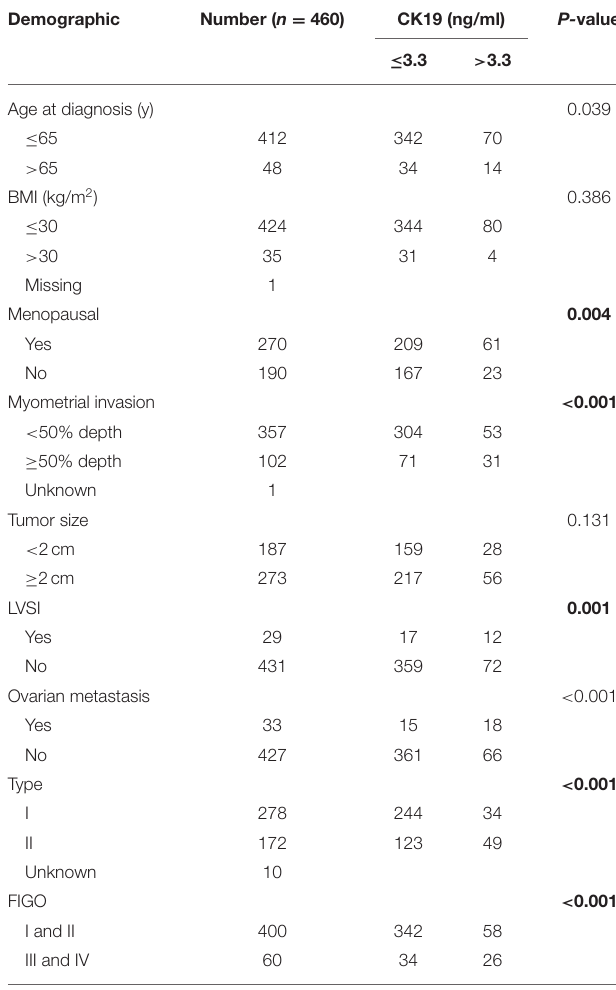
LVSI, lymphovascular space invasion. Bold values indicate P-value are statistically significant (P-value <